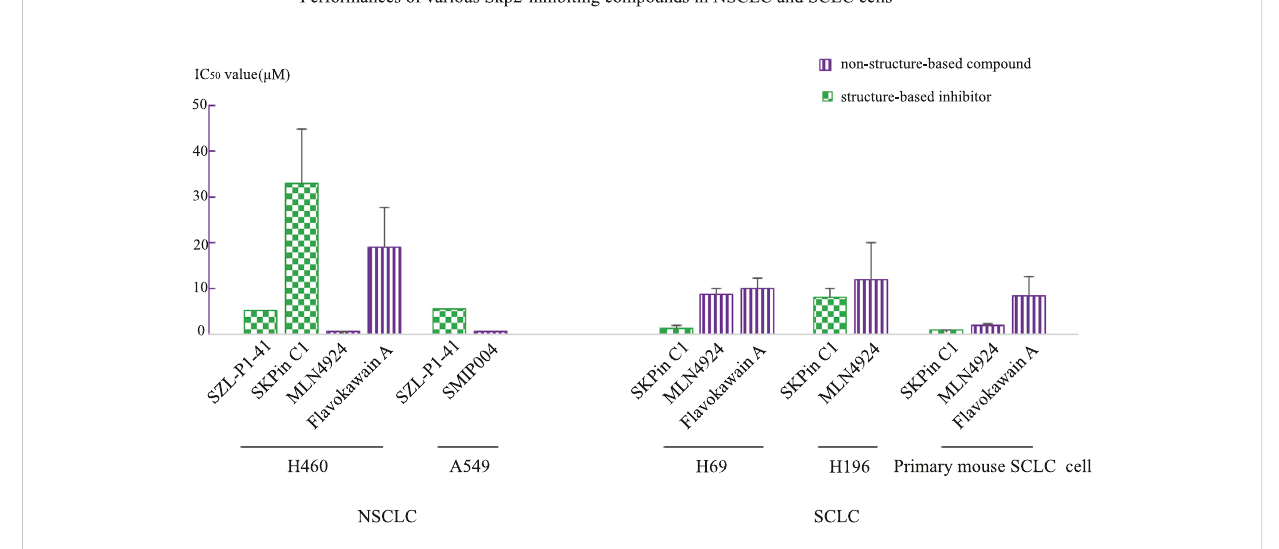
FIGURE 1 Comparison of IC 50 values between structure-based Skp2 inhibitors and non-structure-based compounds in NSCLC and SCLC cell